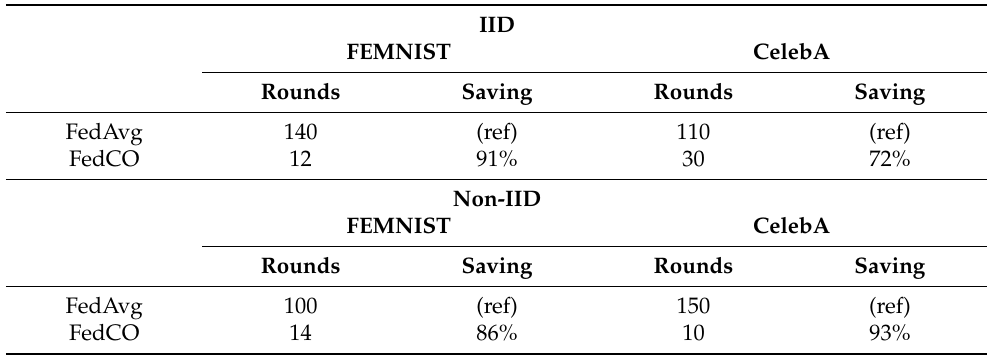
Table 5. The number of communication rounds to reach a certain accuracy level for the two compared FL algorithms on each LEAF